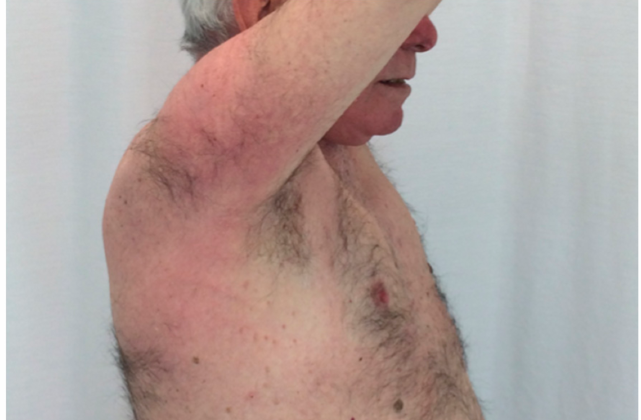
Figure 4. Rigid sclerodermoid lesions on right arm and shoulder in a patient with IgG kappa monoclonal